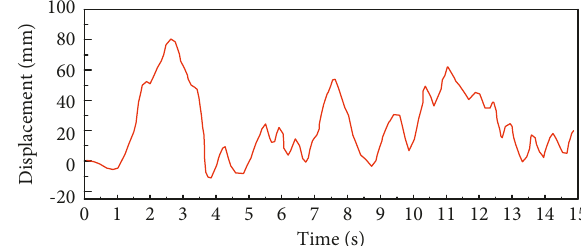
Figure 12: Horizontal displacement time curve of frame column at observation point 1.